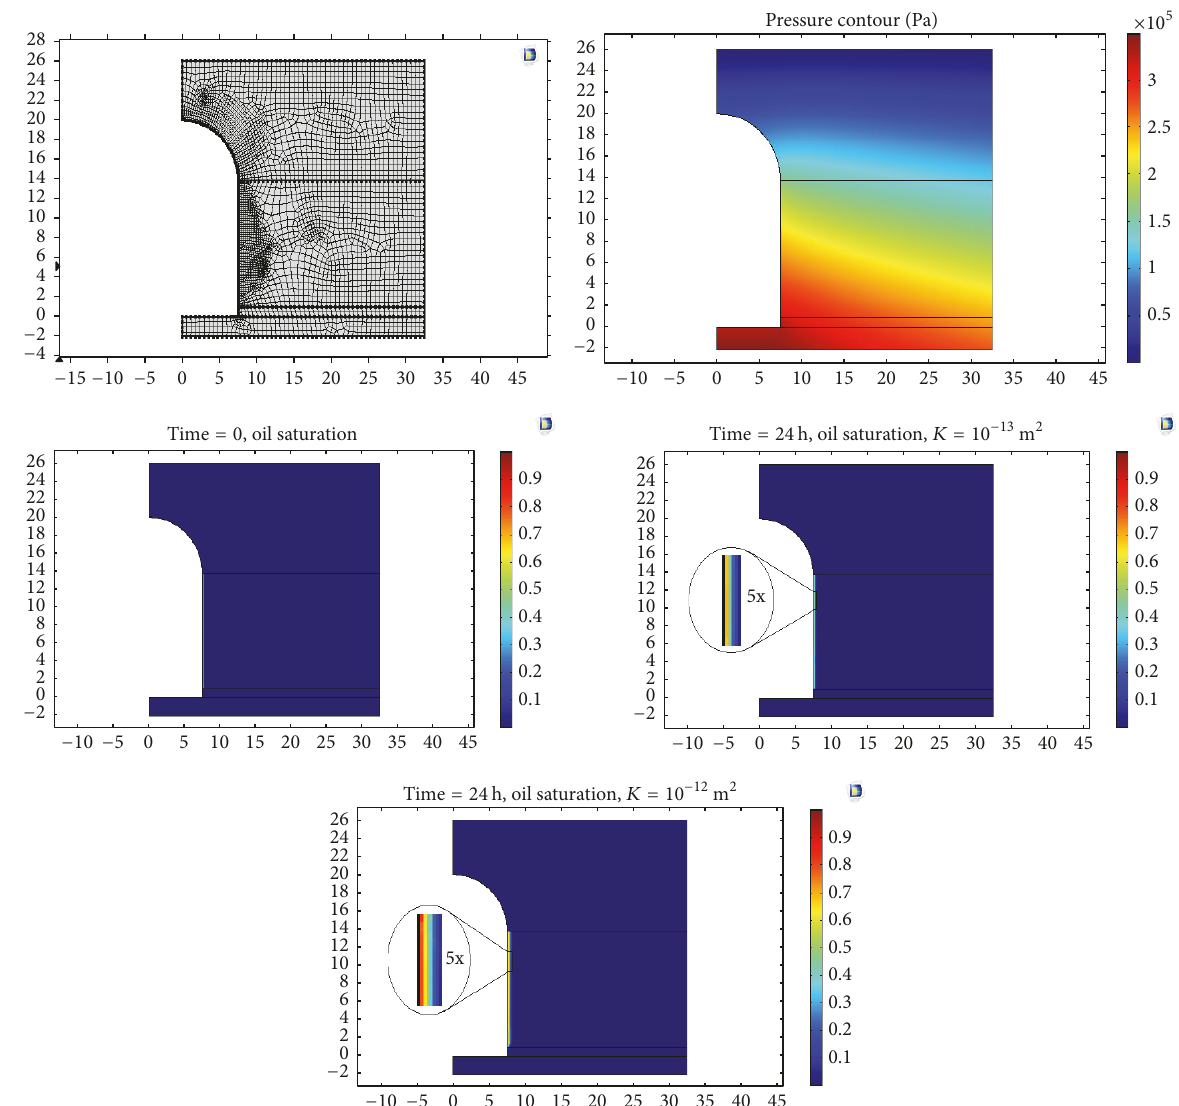
Figure 4: Finite element mesh as well as pressure and oil saturation contours of the example of oil seepage